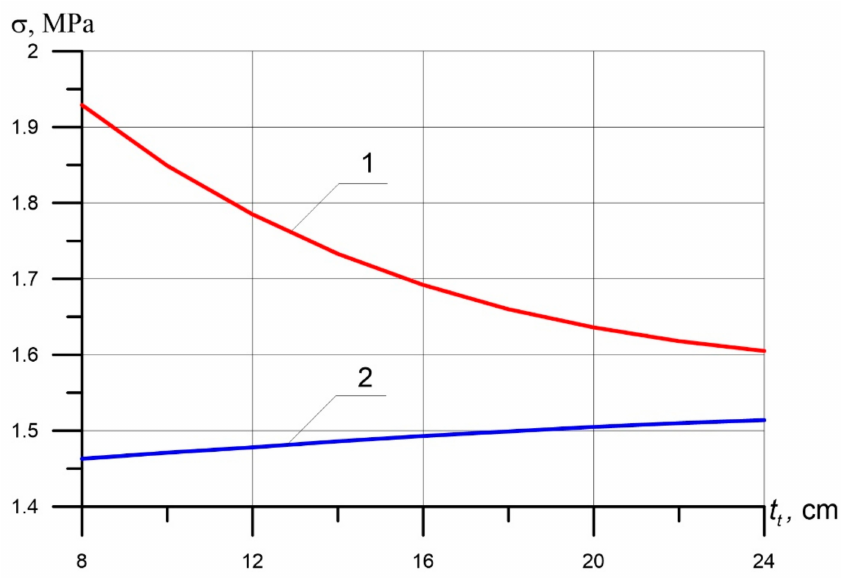
Figure 5. Dependences of dynamic stresses on the thickness of the I-beam flange t t in the tension zone without taking into account the mass of the fiber-reinforced concrete beam, ( 1 ) dynamic tensile stress; ( 2 ) dynamic compressive stress.